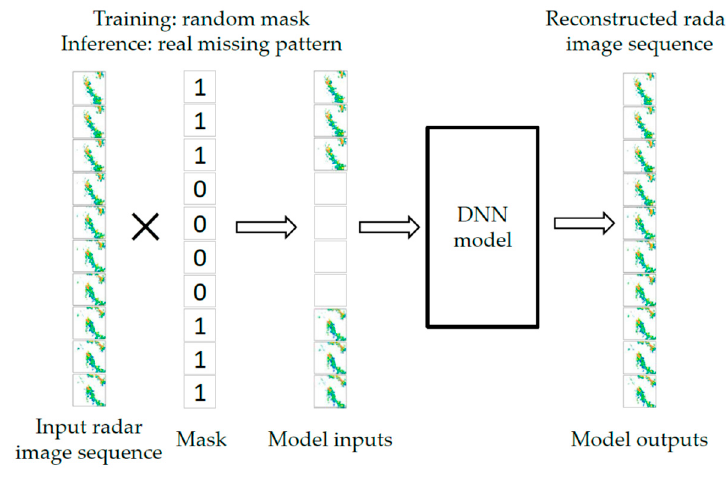
Figure 4. Scheme chart for the masking procedure and the deep neuron network (DNN) model.